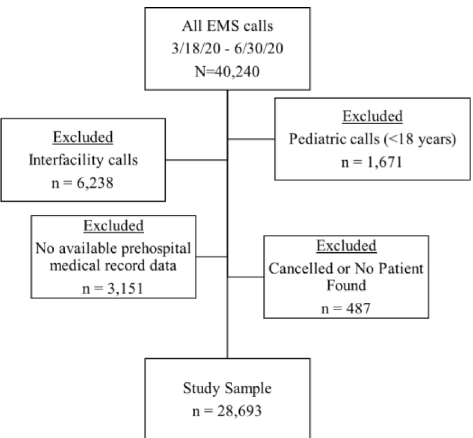
Figure. CONSORT* flow diagram for confirming eligibility. *CONSORT, Consolidated Standards of Reporting Trials.